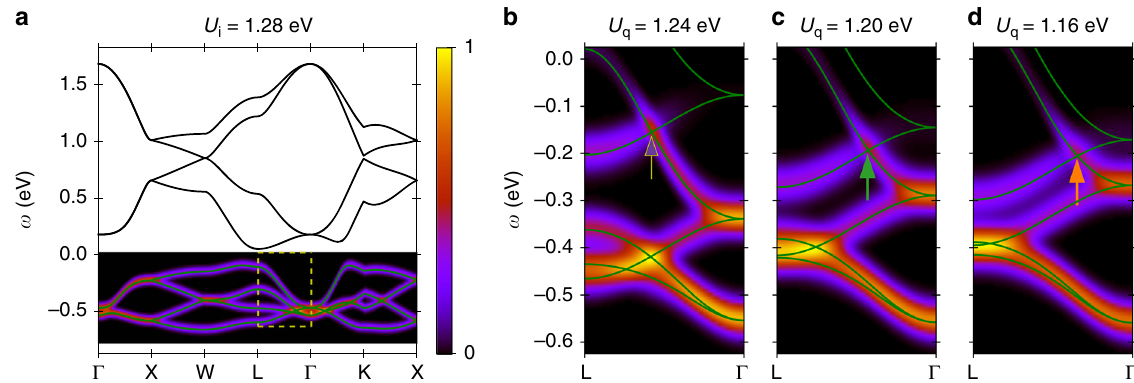
Fig. 3 Time-resolved ARPES detection of Weyl fermions. a Calculated photocurrent from tr-ARPES of the equilibrium band structure along high-symmetry path for an initial AFI state ( U i = 1.28 eV, t σ = − 0.62 eV) at T = 0.016 eV. The conduction bands are separated from the valence bands by an energy gap E ≈ 0.15 eV (AFI) at the L point. The yellow square highlights the region of interest. b – d tr-ARPES band structure along the high-symmetry line L − Γ at G probe time t p = 123.4 fs. The quenched interaction values, U q = 1.24, 1.20 and 1.16 eV, correspond to increasing Δ U between initial and quenched U and thus stronger driving fi elds. The black solid lines show the instantaneous band structures of the Hamiltonian at t = t p . The coloured arrows indicate the dynamically generated Weyl points. The Weyl cones are shifted along the high symmetry line towards the Γ -point with increasing Δ